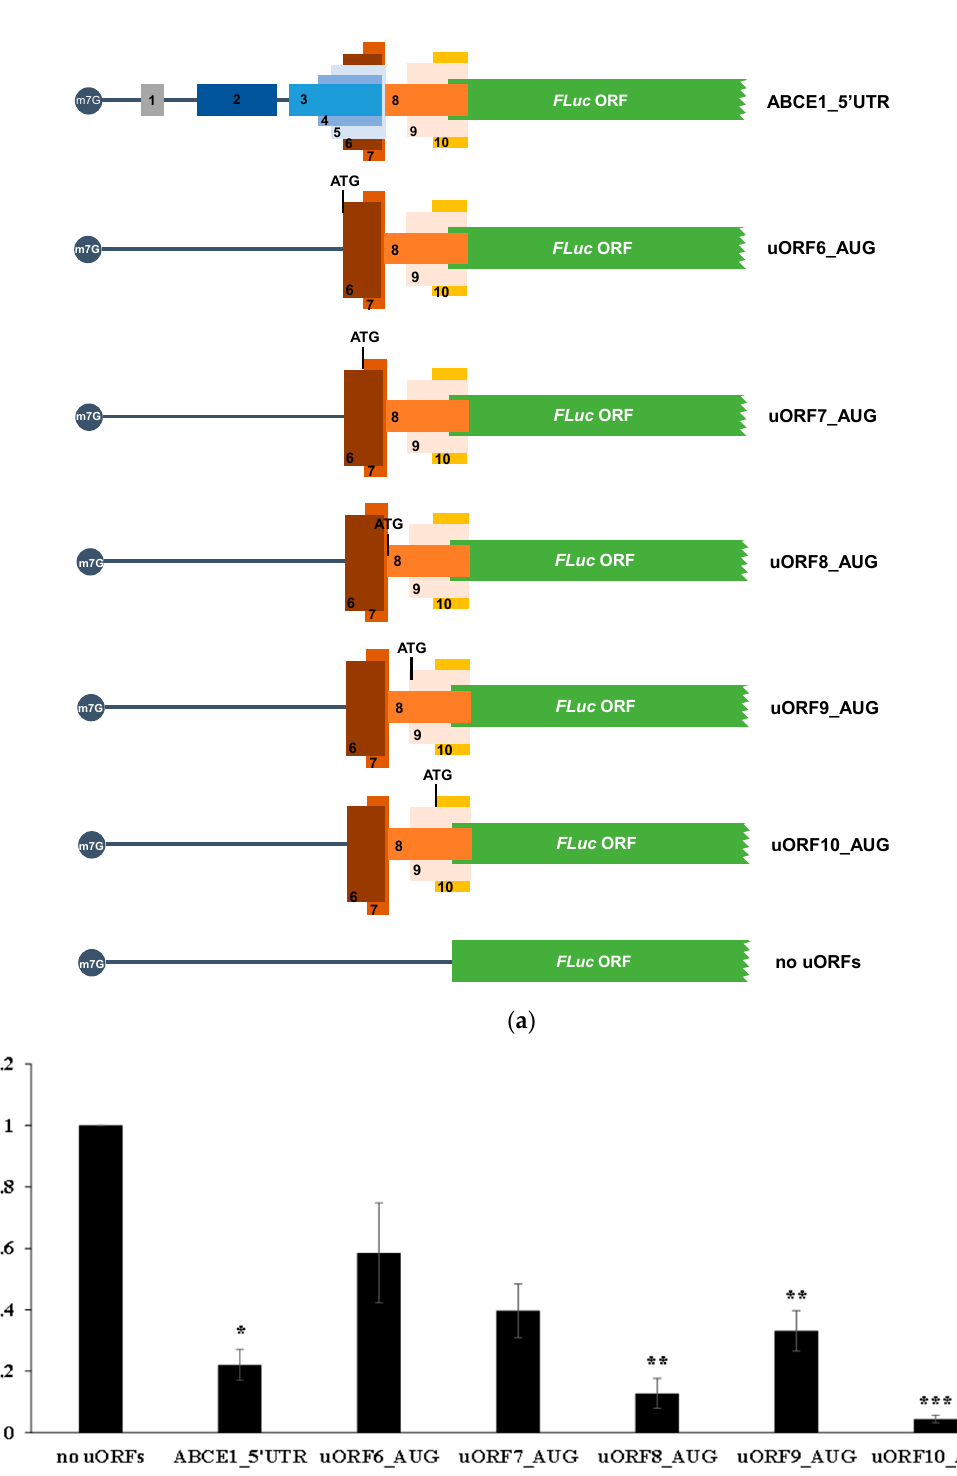
pression of each construct was analyzed as described in Figure 2b legend, but using “no uORFs” construct expression data for the comparison analysis. The results are presented as mean ± SEM from at least three independent experiments. Stu- dent’s t-test was applied for statistical significance: p < 0.05 (*), p < 0.01 (**) and p < 0.001 (***).